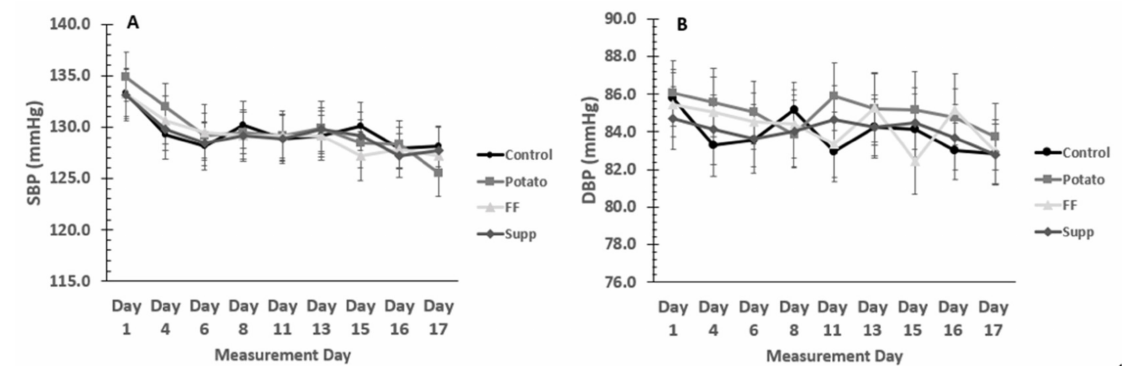
Figure 2. Blood pressure throughout each intervention. ( A ) Systolic blood pressure (SBP) and ( B ) diastolic blood pressure (DBP) means (N = 30) for each measurement day in each intervention phase.